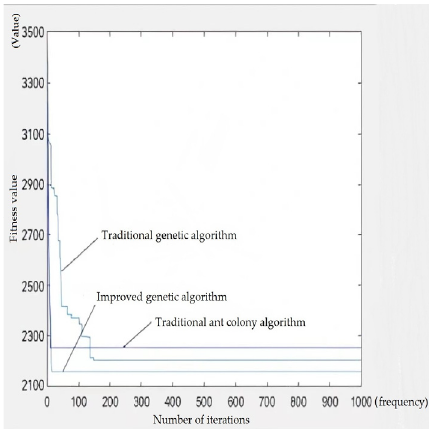
Figure 8. Comparison of fitness values of three algorithms.